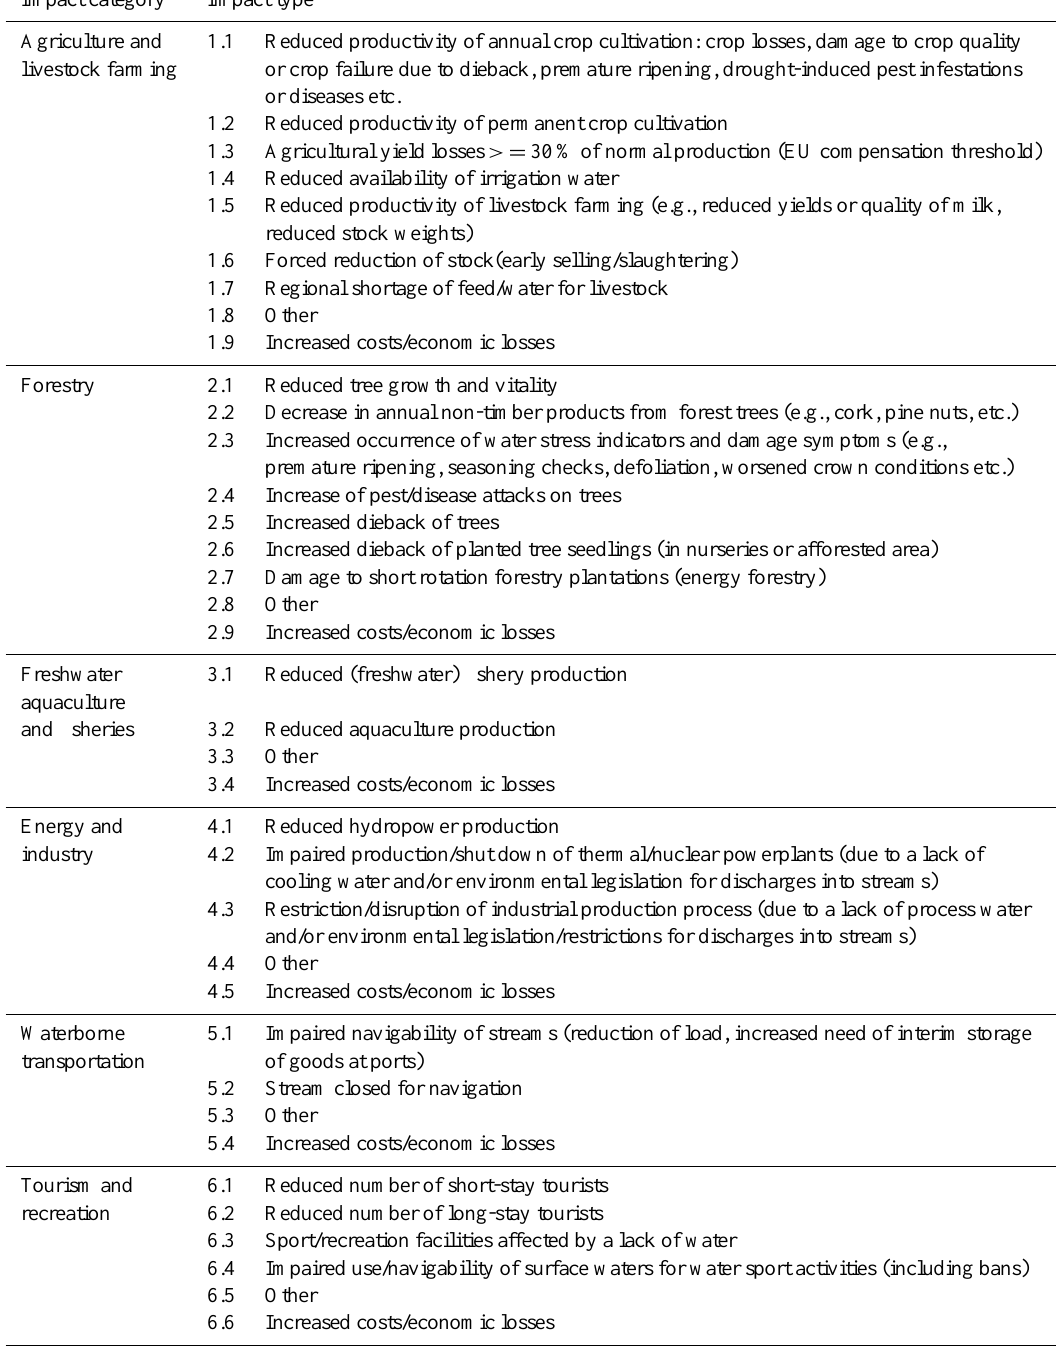
Table A2. EDII Impact categories and type subcategories (modified from Stahl et al., 2012). Impact